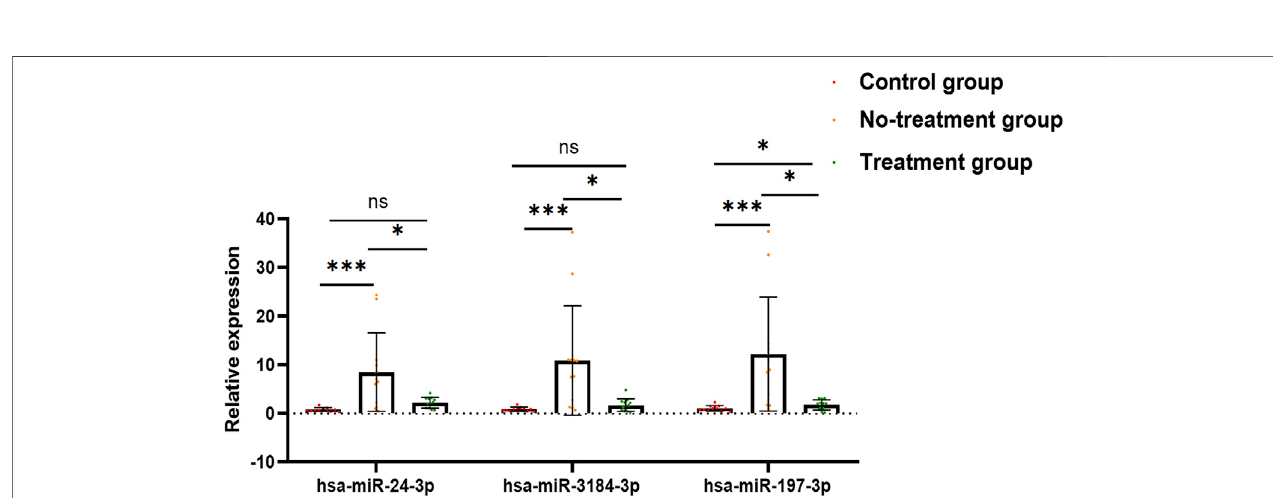
FIGURE 4 | Bar graph exhibits the result of qRT-PCR. Has-miR-24-3p, hsa-miR-3184-3p, and hsa-miR-197-3p were signi fi cantly upregulated in no-treatment group compared with control group, and signi fi cantly downregulated in treatment group compared with no-treatment group. There was no signi fi cant difference in the expressionofhas-miR-24-3pandhsa-miR-3184-3pbetweencontrolgroupandtreatmentgroup( p (cid:2) 0.078, p (cid:2) 0.543).Hsa-miR-197-3pwasupregulatedintreatment group compared to control group. * p < 0.05, ** p < 0.01, *** p < 0.001, ns: no signi fi cance.